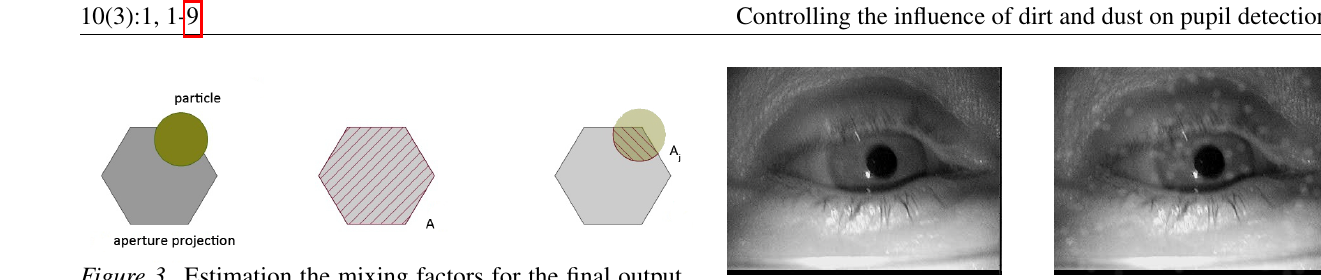
Figure 3 . Estimation the mixing factors for the final output color. The blending factor is calculated as the fraction of each particle of the projected aperture area.